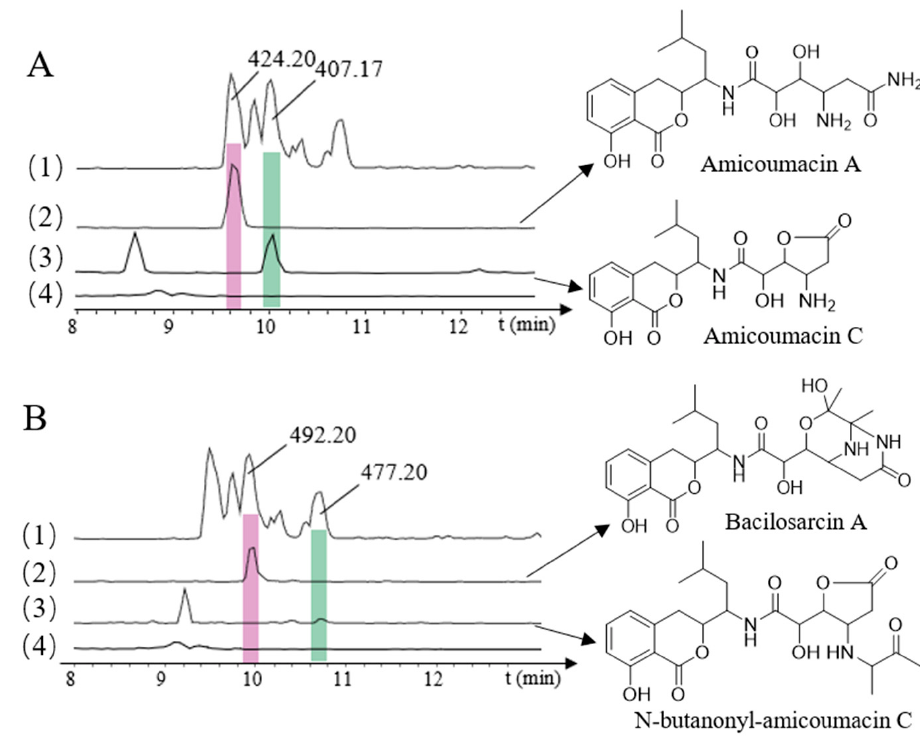
Figure 3. HPLC-MS analyses of heterologously produced amicoumacins. ( A ): (1) B. subtilis fmb60, (All MS); (2) Amicoumacin A ( m/z 424.20) (3) Amicoumacin C ( m/z 407.17); (4) E. coli GB05-MtaA, blank; ( B ): (1) B. subtilis fmb60, (All MS); (2) Bacilosarcin A ( m/z 492.20); (3) N -butanonyl-amicoumacin C ( m/z 477.20); (4) E. coli GB05-MtaA, blank.